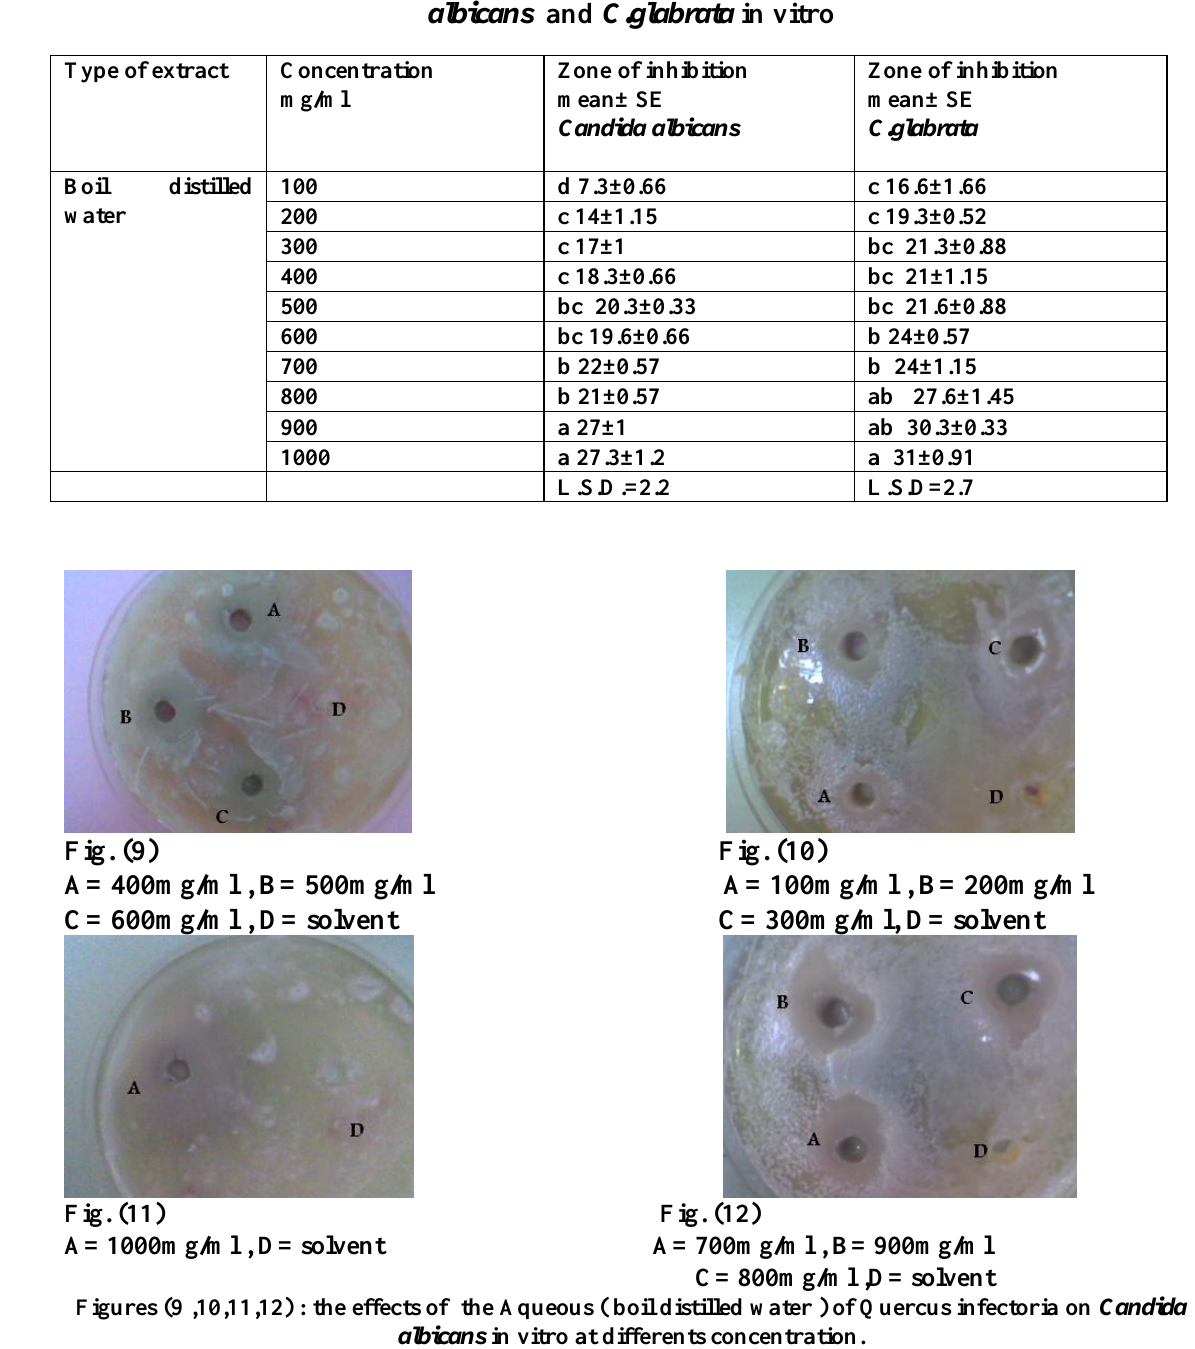
Table 3: The effects of Aqueous ( boil distilled water ) of Quercus infectoria on